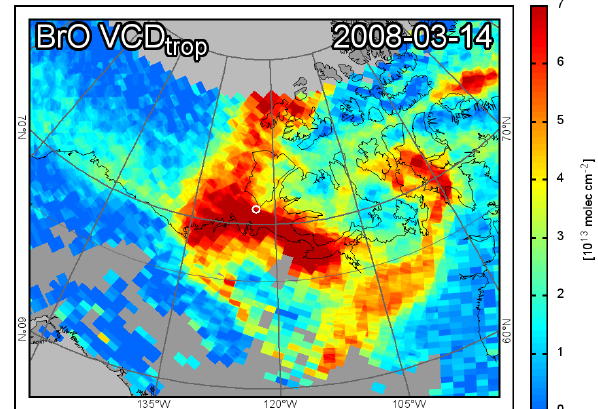
Fig. 14. Same as Fig. 13 but showing BrO mixing ratios measured by LP-DOAS. Both ordinates are scaled corresponding to a mixing height of 345m. Correlation in Fig. 18b.